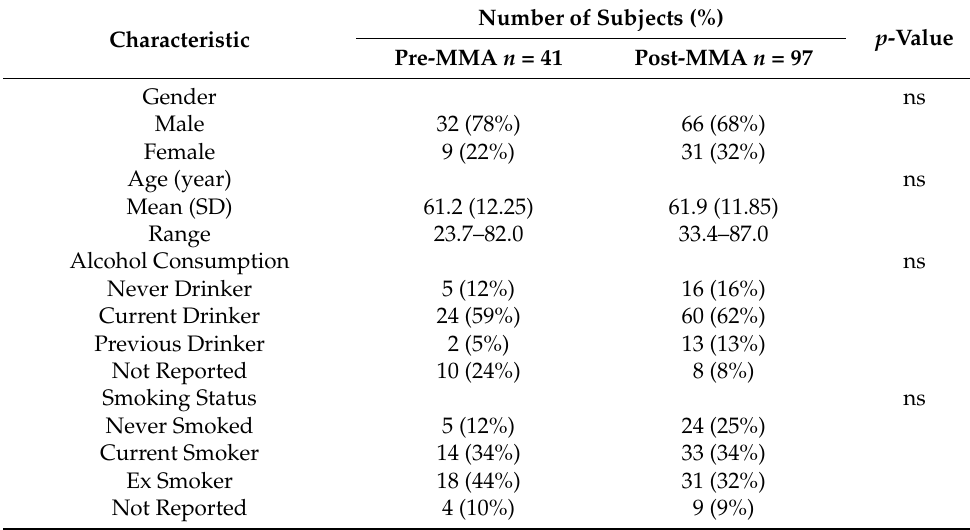
Table 1. Clinical